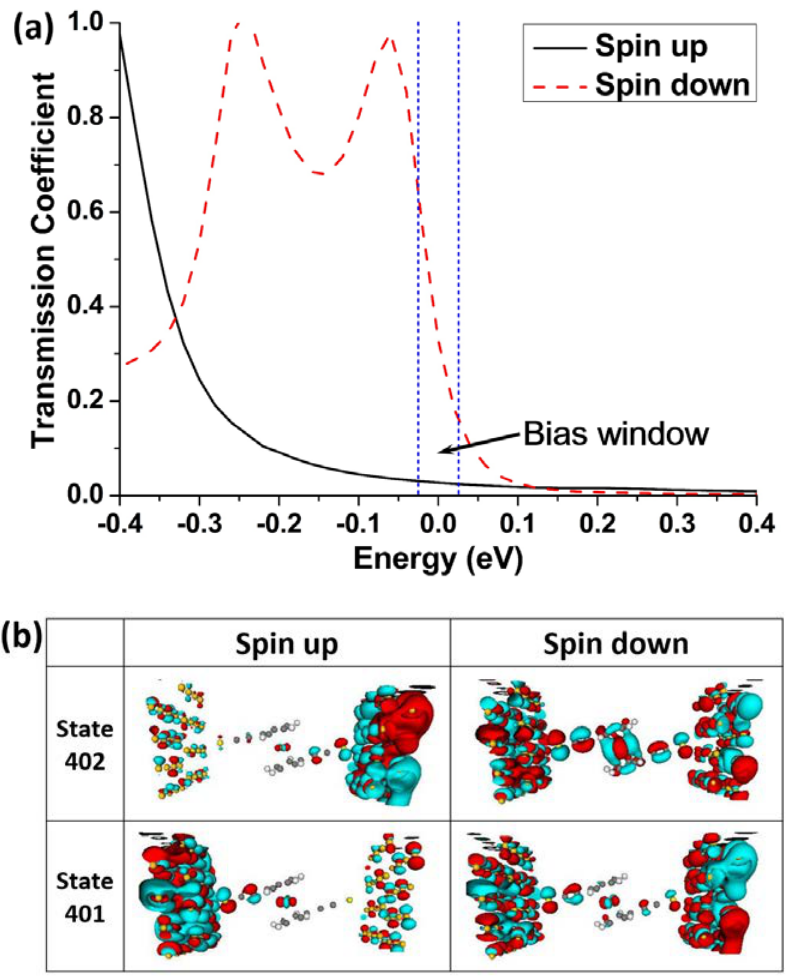
Figure 7. ( a ) Spin-up and spin-down transmission spectra at 0.05 V for model M2; ( b ) Spatial distribution of the molecular projected self-consistent Hamiltonian (MPSH) states 401 and 402 at 0.05 V for model M2. The isovalue is 0.03.